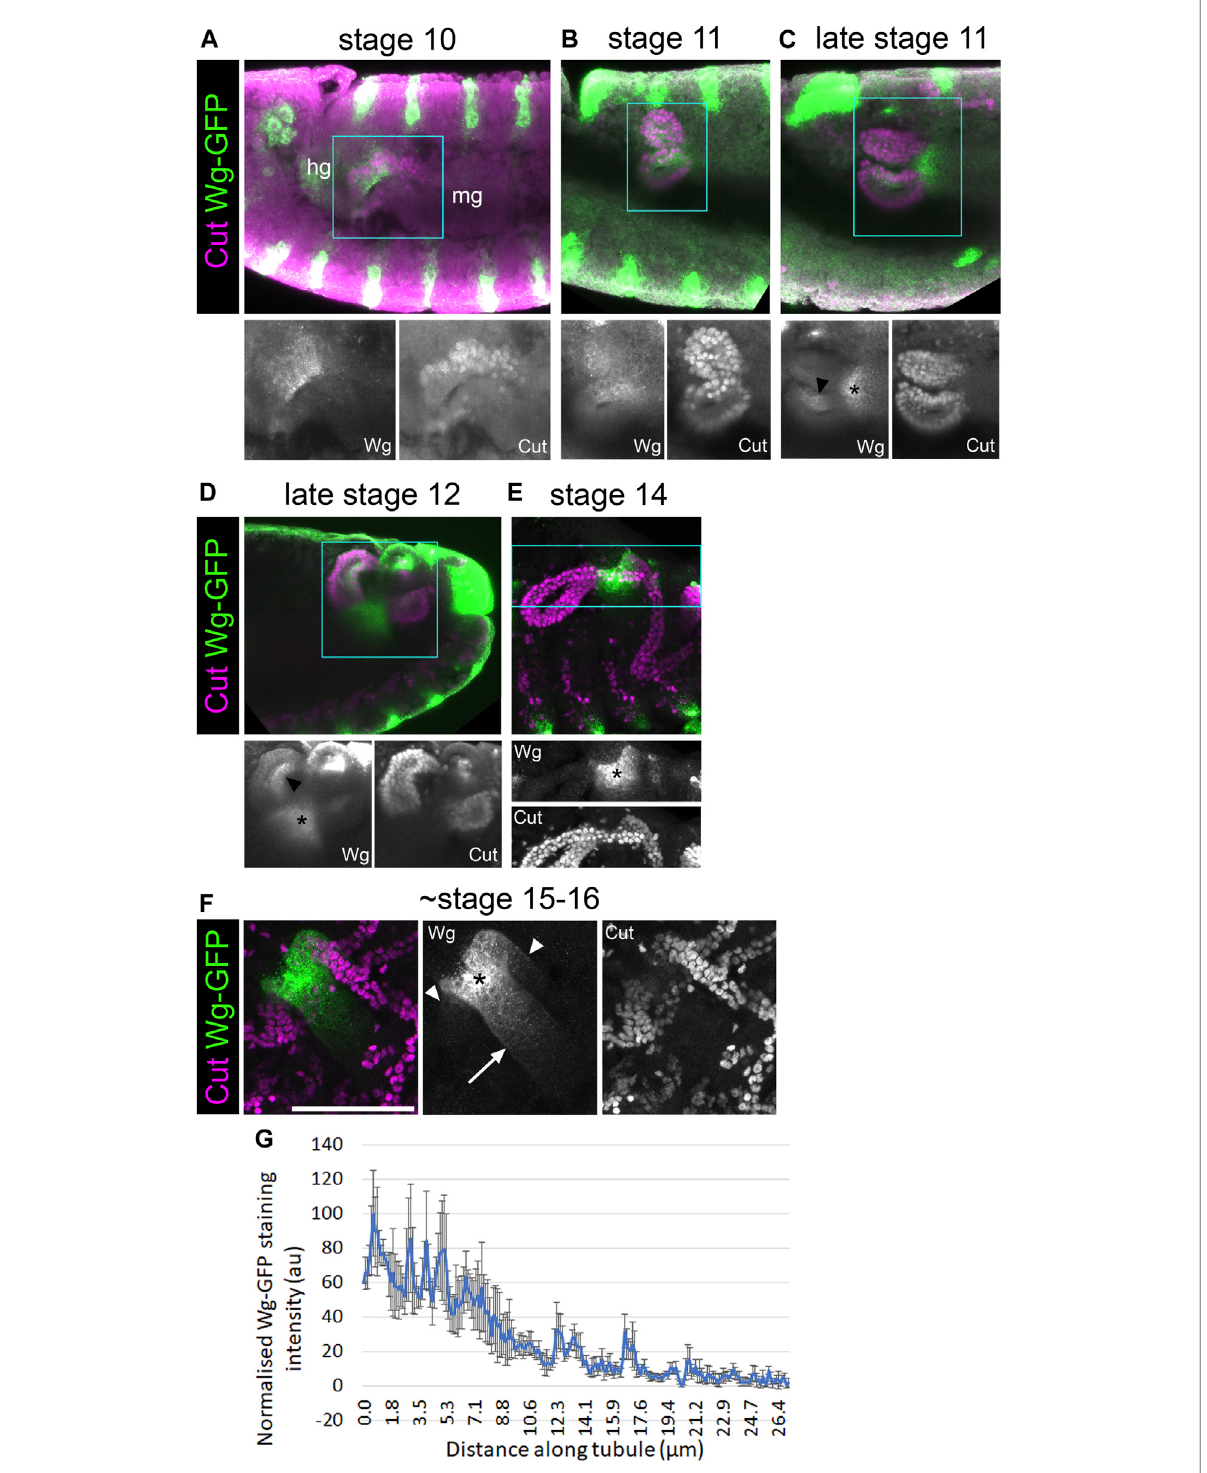
FIGURE 8 Wingless is present in the half of the tubule primordium that abuts the developing hindgut. (A – E) ~Stage 10 – 16 embryos expressing Wg-GFP, stained with anti-GFP, along with anti-Cut to show nuclei of MpT cells. Wg-GFP can be observed in (A) MpT cells closest to the hindgut as the MpTs begin budding out at stage 10, (B – D) on one side of the MpTs at stage 11 – 12 (arrowheads in C + D), (C – E) and a gut region near the midgut-hindgut boundaryattheproximalMpTendsfromlatestage11. (F) Inalatestage(~stage15 – 16)embryo,Wg-GFPlocalisesmoststronglytoaregionnear